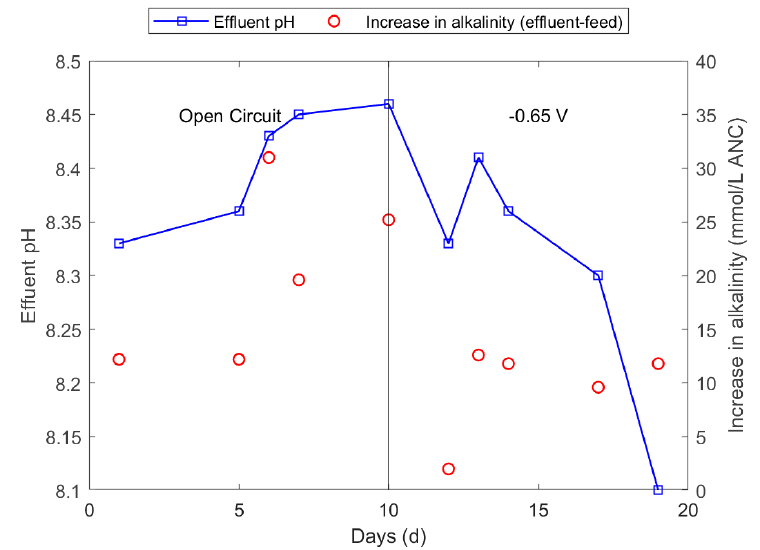
Figure 8. Comparison of pH and alkalinity in open circuit and MES mode operations.